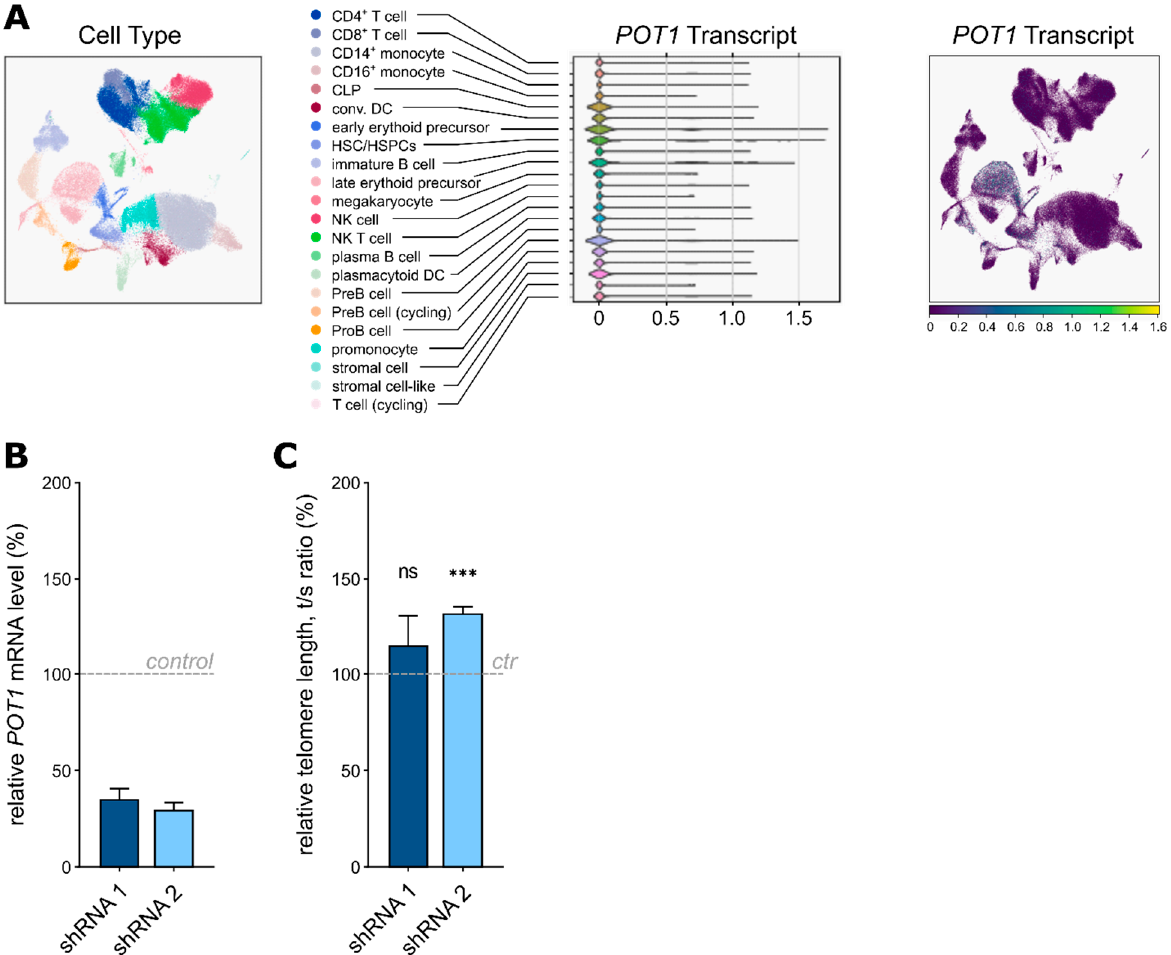
Figure 5. ( A ) Principal component analyses of the single-cell RNA sequencing data displaying POT1 expression within the healthy human bone marrow. CLP: common lymphoid progenitor, DC: dendritic cell, HSC: hematopoietic stem cell, HSPC: hematopoietic stem and progenitor cell, NK: natural killer cell. ( B ) QRT-PCR analysis confirming downregulation of POT1 in the HL-60 cells carrying shRNA 1 and 2 compared to the nontargeting shRNA control. ( C ) Relative telomere length (rTL) analysis by qRT-PCR (comparative ΔΔ Ct method) with DNA isolated from the HL-60 samples; shRNA 2 showed significant telomere elongation compared to the nontargeting shRNA control (ctr). ns = p > 0.05, *** = p ≤ 0.001.